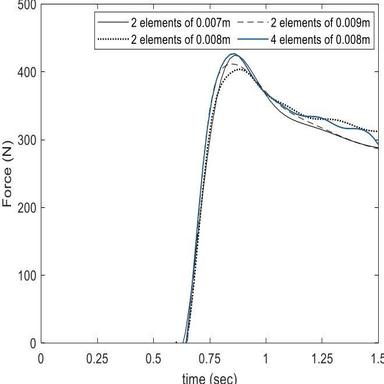
Detail of the discretised domain in the vicinity of the obstacle. Fig. 11. Sensitivity study on the mesh size and number of elements along z for 55◦ flume setup.